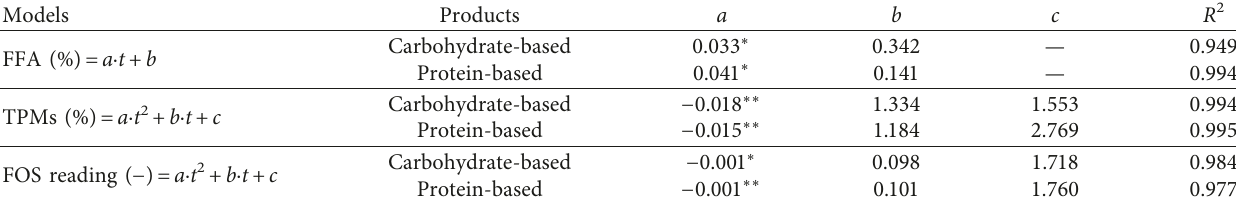
Figure 5: Scatter plots and regression lines of chemical qualities: (a) FFA; (b) PV; (c) TPM; and (d) FOS reading of frying oil as a function of time ( t ). Table 2: Regression results for chemical qualities of frying oil as a function of time ( t ). Models